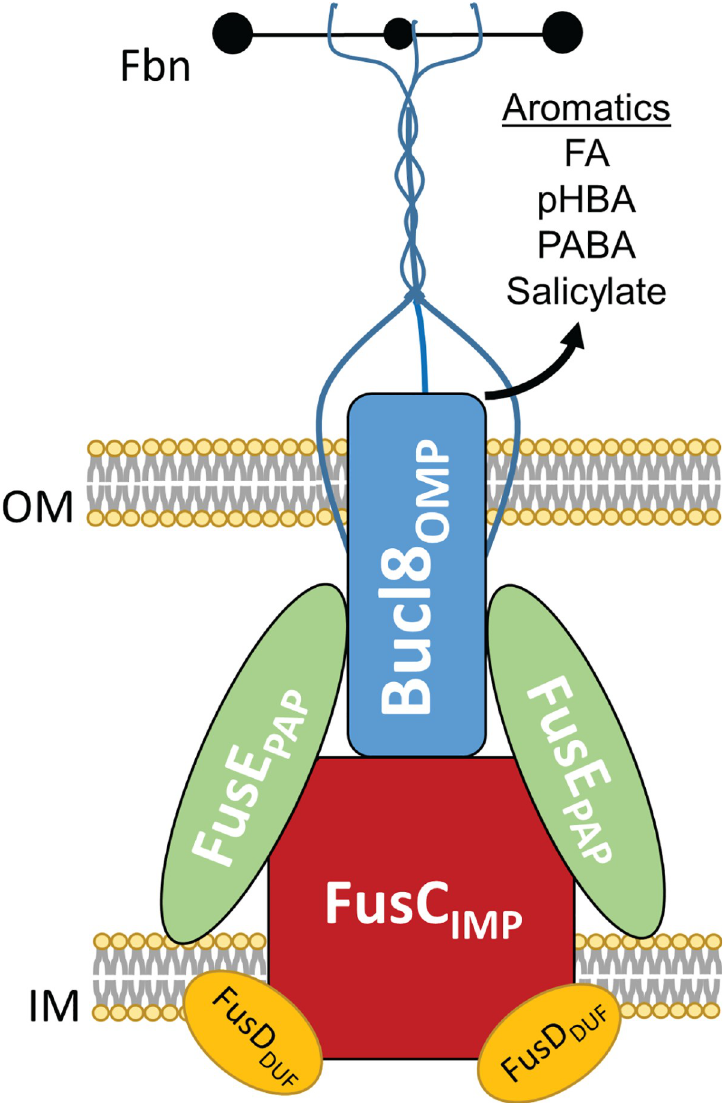
Fig 7. Model of assembled Bucl8-associated efflux pump components and substrates. Cartoon representation of assembled the Bucl8-associated efflux pump components: Bucl8 OMP , FusC IMP , FusD DUF, and FusE PAP . The extended CL-Ct structure is predicted to transverse the outer membrane into the extracellular space and to bind fibrinogen (Fbn). Aromatic substrates, such as experimentally-confirmed fusaric acid (FA) and p- hydroxybenzoic acid (pHBA), as well as putative p- aminobenzoic acid (PABA) and salicylate, are shown. OM; outer membrane. IM; inner membrane.